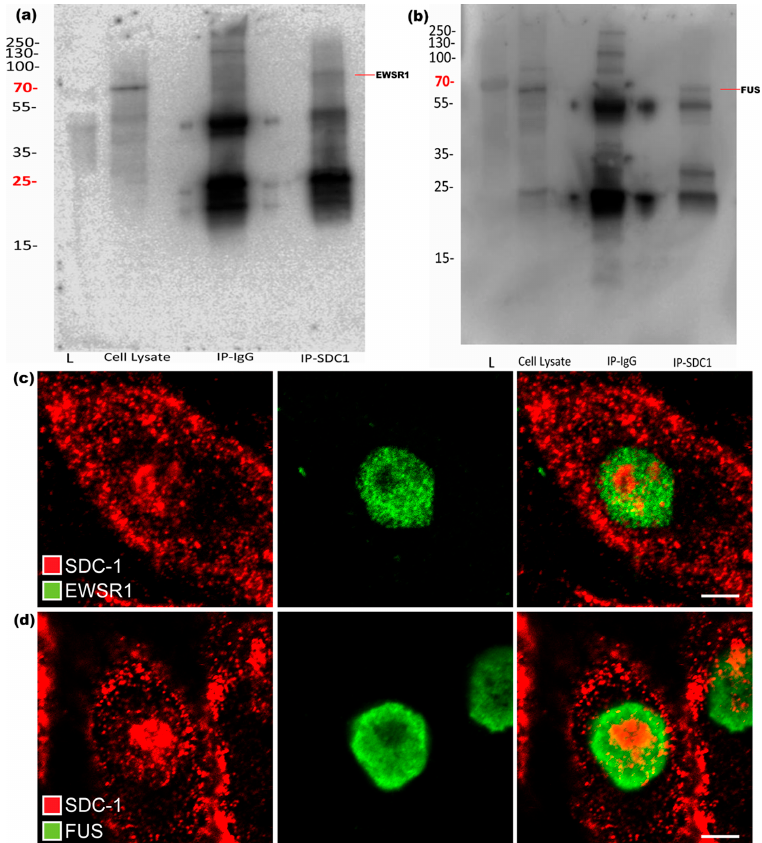
Figure 3. Validation of interaction between SDC1 and EWSR1 or FUS, respectively. Western blots of SDC1 immunoprecipitates. ( a ) The blot shows presence of EWSR1. ( b ) The presence of FUS in SDC1 immunoprecipitate. “L” represents ladder in both the blots. ( c , d ) The figure shows the presence of SDC1 (red) along with EWSR1 (green) and FUS (green) in the nucleus,